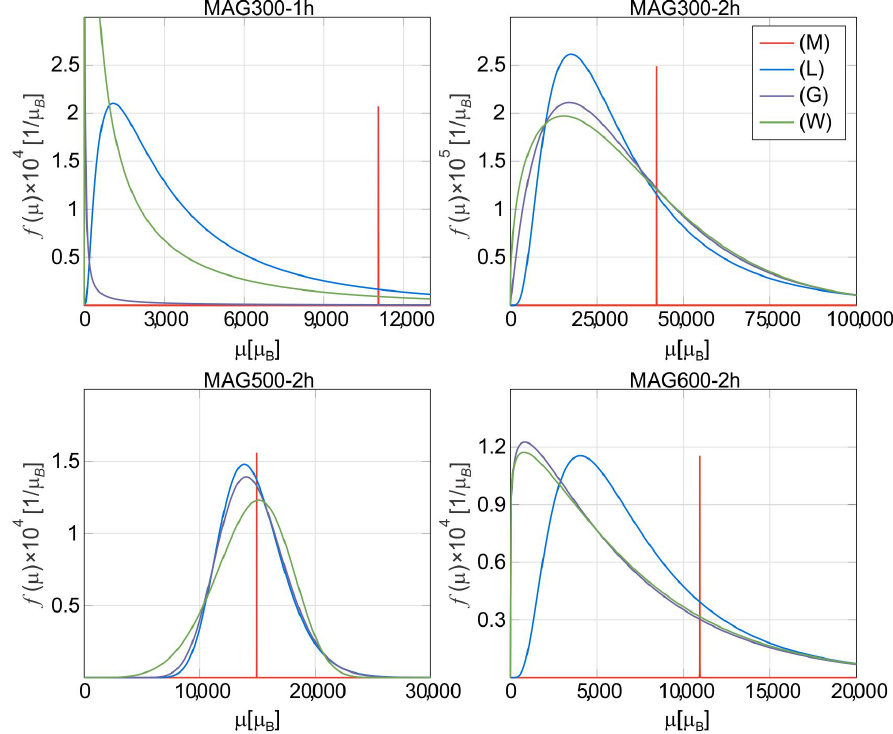
Figure 2. Representation of the probability density functions used to fit the magnetization curves of the Mag300-1h, Mag300-2h, Mag500-2h and Mag600-2h